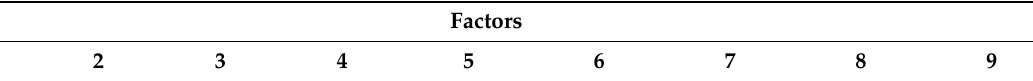
Table A2. Factorial loads of the